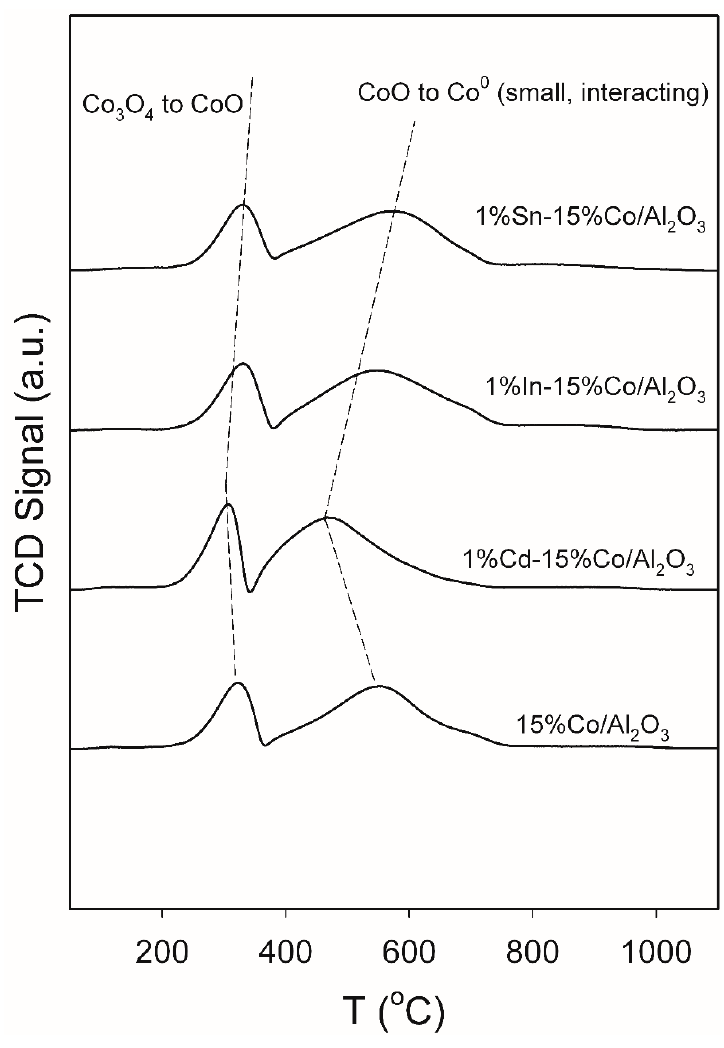
Figure 1. TPR profiles of, moving upward, 15%Co/Al 2 O 3 , 1%Cd-15%Co/Al 2 O 3 , 1%In-15%Co/Al 2 O 3